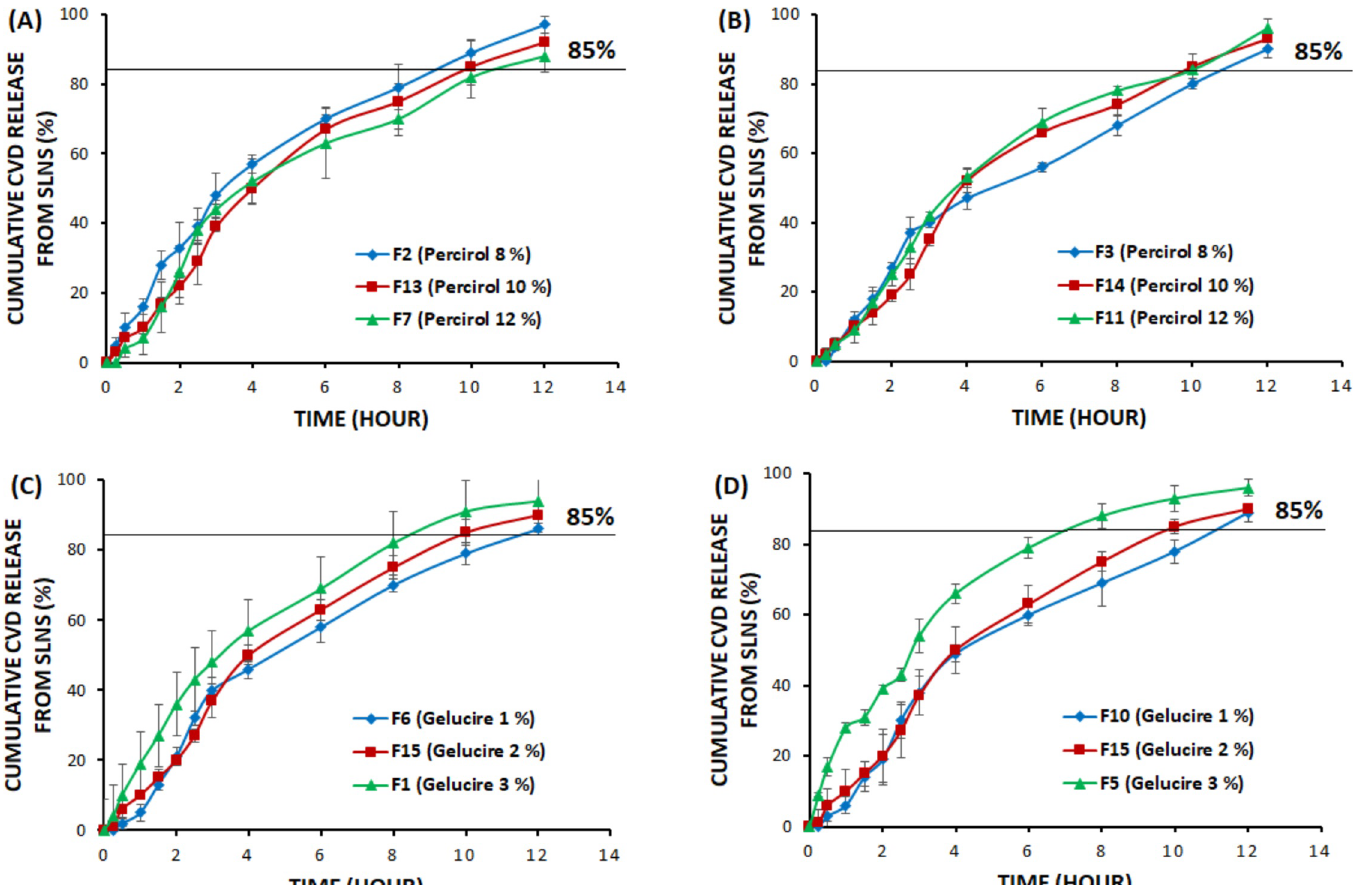
Fig 1. In vitro release profiles for CVD-SLN formulations with different concentrations of Percirol ATO5 and Gelucire 44/14. As a result of overlapping, error bars are omitted for clarity.